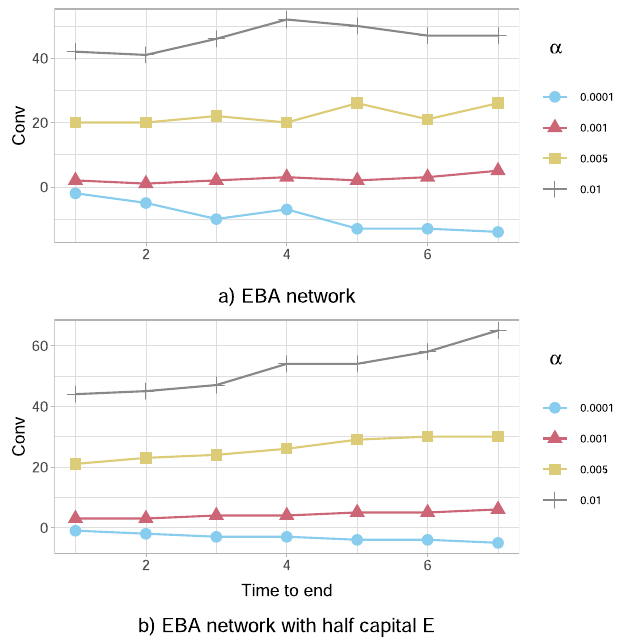
Fig.5|TheconveniencetointerveneConvfortheEuropeanBankingAuthority (EBA)networkasafunctionoftimetotheendofcrisis.a TheConv(inmillionsof EUR) de fi ned in (23) is positive for higher percentages of wealth loss upon default ( α =0.01, 0.005, 0.001),thus investing isafavourable action. Conversely, Conv<0 forsmaller α ( α =0.0001),implying that itis notconvenient for the government to invest. Conv tends to be an increasing function of the time to the end of the crisis when positive, and a decreasing function when negative. b A severely distressed versionofthenetwork,wherethebanks'capital E i (0)hasbeenarti fi